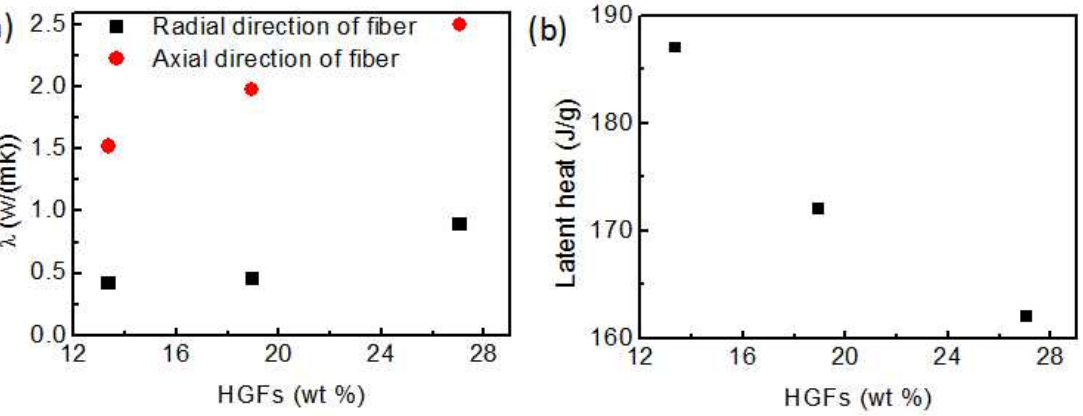
Figure 5. Thermal conductivity ( a ) and latent heat ( b ) of the HGFs/Paraffin composite PCM with mass ratio of the HGFs.